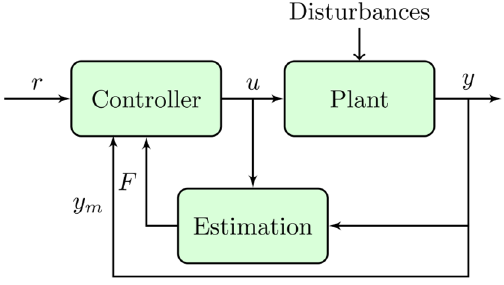
Figure 4. The structure of the ultra ‐ local model.